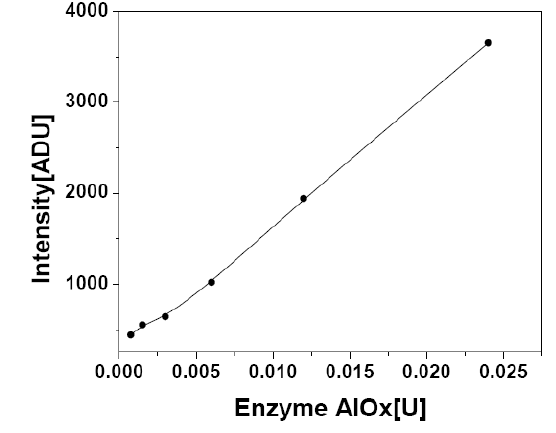
Figure 1. Graph showing the optimization of AlOx concentration for proposed bi-enzyme reaction plate